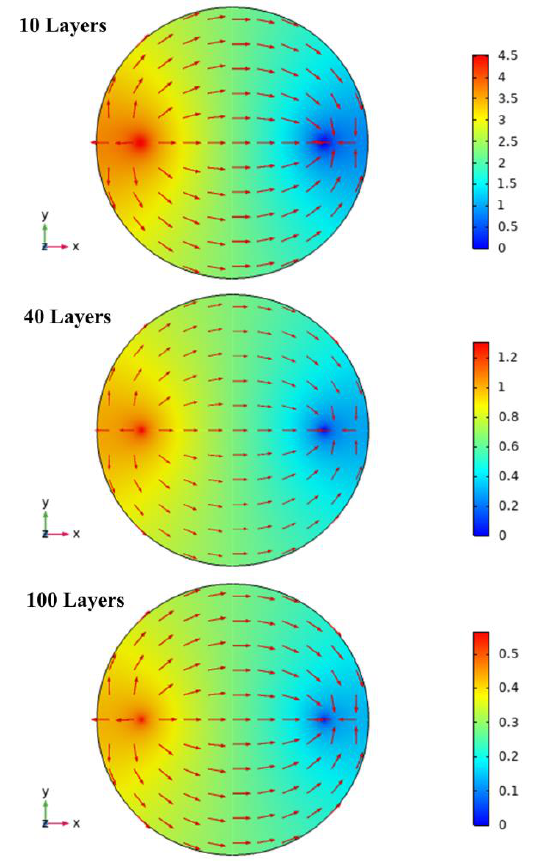
Figure 19. Potential and electric field color plots of simulated thin films.